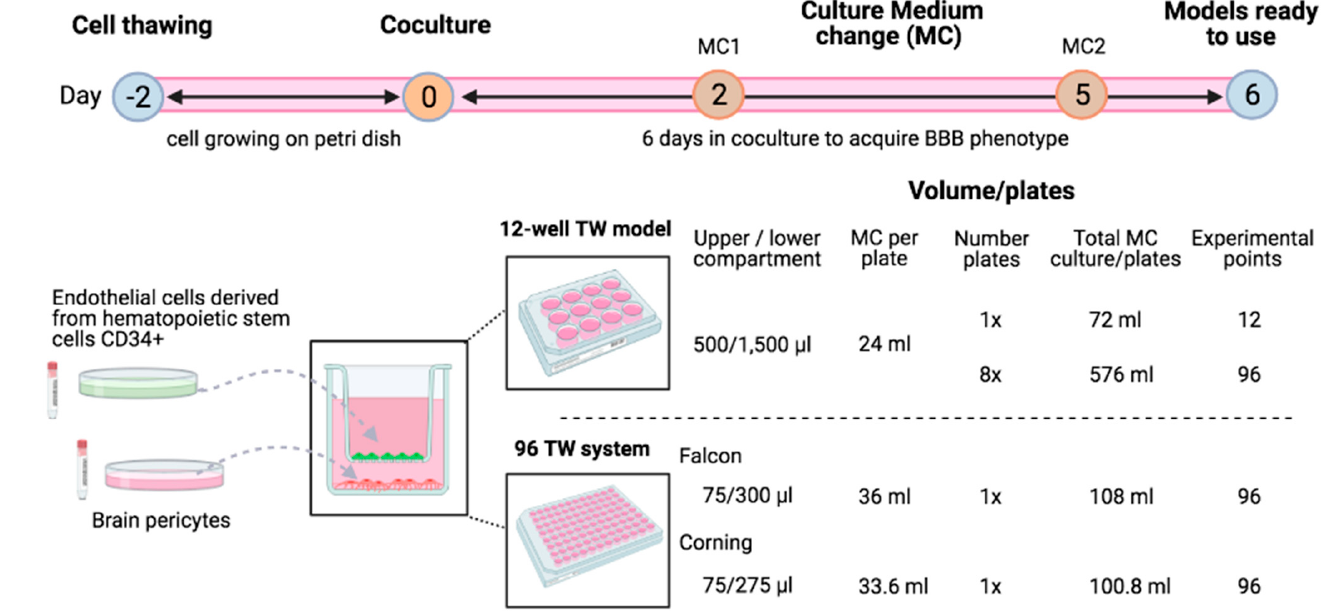
Figure 1. Schematic representation of the cell culture process to develop the noncontact coculture humanin vitroBBB models using endothelial cells (ECs) derived from human hematopoïetic stem cells and bovine brain pericytes. Cells were thawed in petri dishes and let grown for 2 days. Then, cocultures were settled by seeding human ECs in the filters and brain pericytes in the bottom compartment either for 12-well plates or miniaturized 96 TW systems. After 2 media changes (MC), experiments were then realized on day 6 of the coculture needed to acquire the BBB phenotype. Volume of the culture medium used regarding the type and number of plates was detailed. Image created with BioRender.com (accessed on 15 April